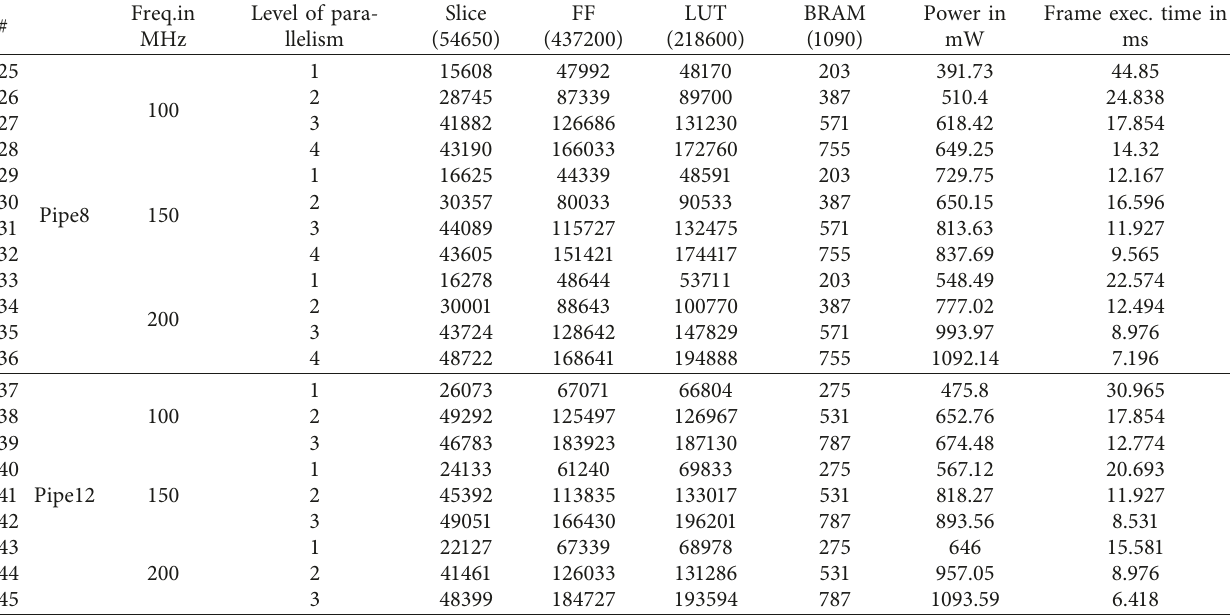
Table 5: Estimations for utilization, power, and frame execution time for pipe8 and pipe12